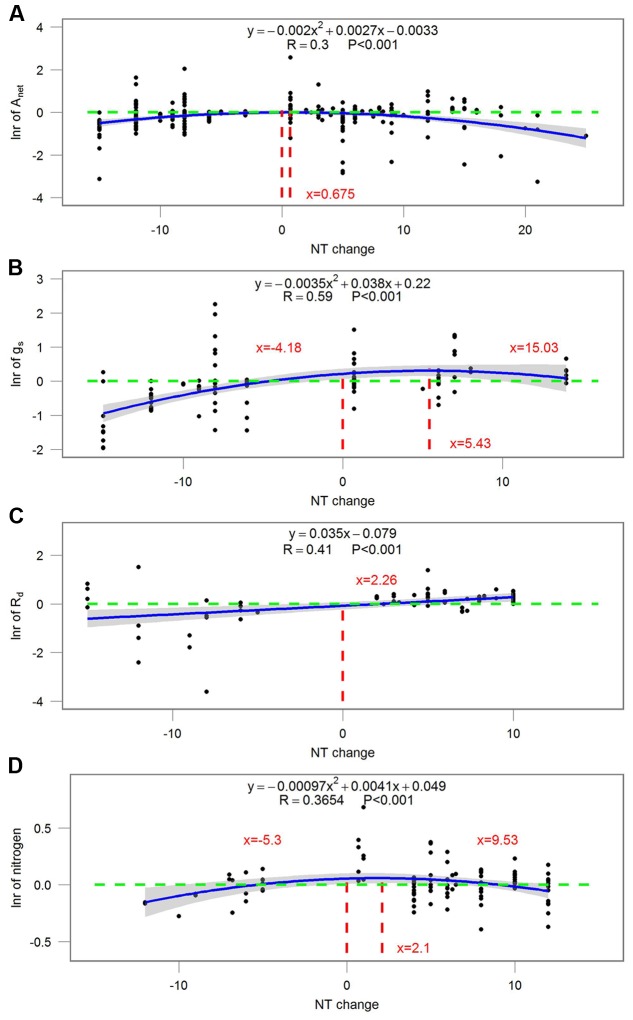
Correlations between the magnitude of NT treatment and the response ratio of (A) net photosynthetic rate (Anet); (B) stomatal conductance (gs); (C) dark respiration rate (Rd) and (D) tissue nitrogen content (N). Each point represents response ratio (lnr) to HNT or LNT. Regression function, variation coefficient and p-value are presented in the middle of each graph. Different lines indicate X = 0 (red line), x-value when y is the maximum, crossing points of y = 0 (green line) and regression relationships. Note that N is tissue nitrogen content including stem, leaf, panicle, spike, grain, shoot, root, and total N.